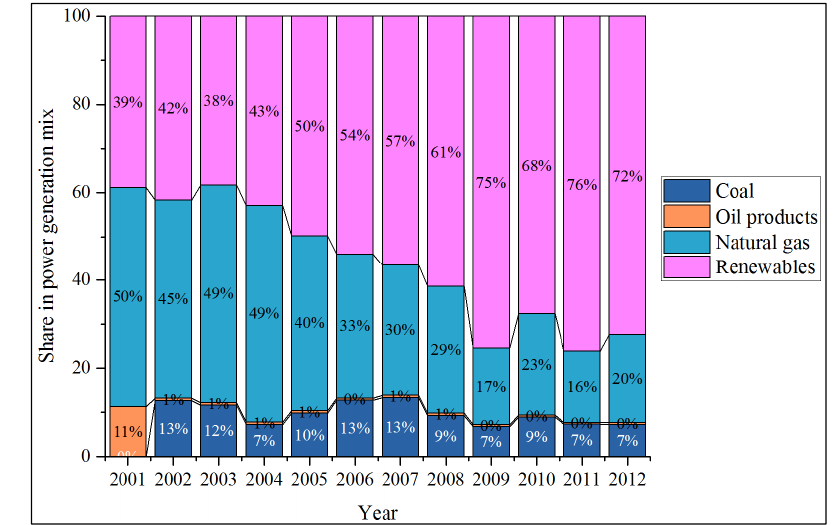
Figure 15. Myanmar: power generation mix.